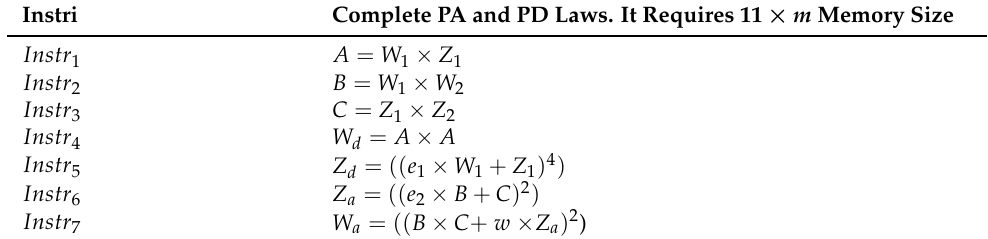
Table 1. Differential PA and PD formulations for BEC [21].